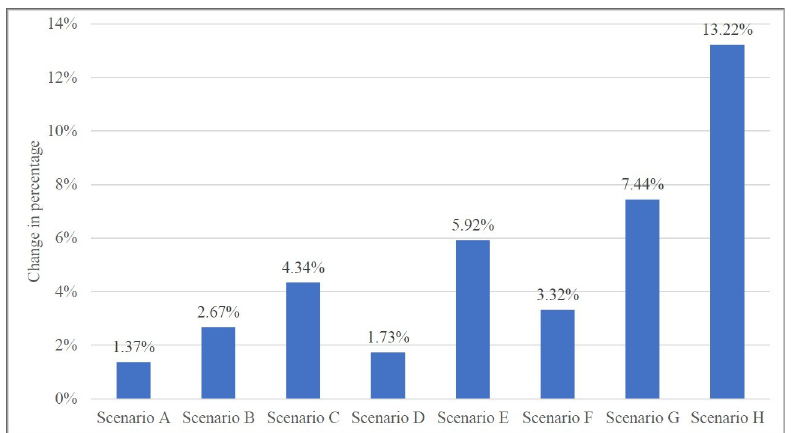
Fig 2. Percentage change of obesity prevalence (BMI � 25 kg/m 2 ) from eight sensitivity analysis scenarios.